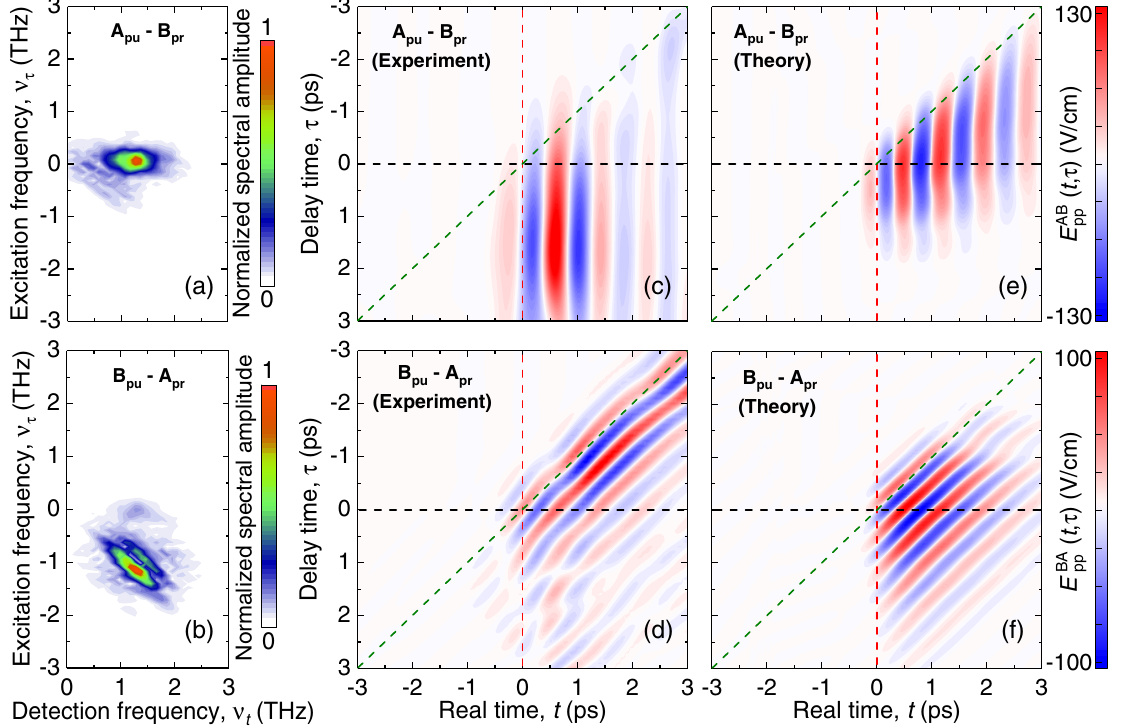
FIG. 5. The 2D-filtered pump-probe signals: (a) A Contour plots of the Fourier-back-transformed E AB The green and red dashed lines indicate the position of the driving fields A and B, respectively, while the black dashed line indicates zero delay